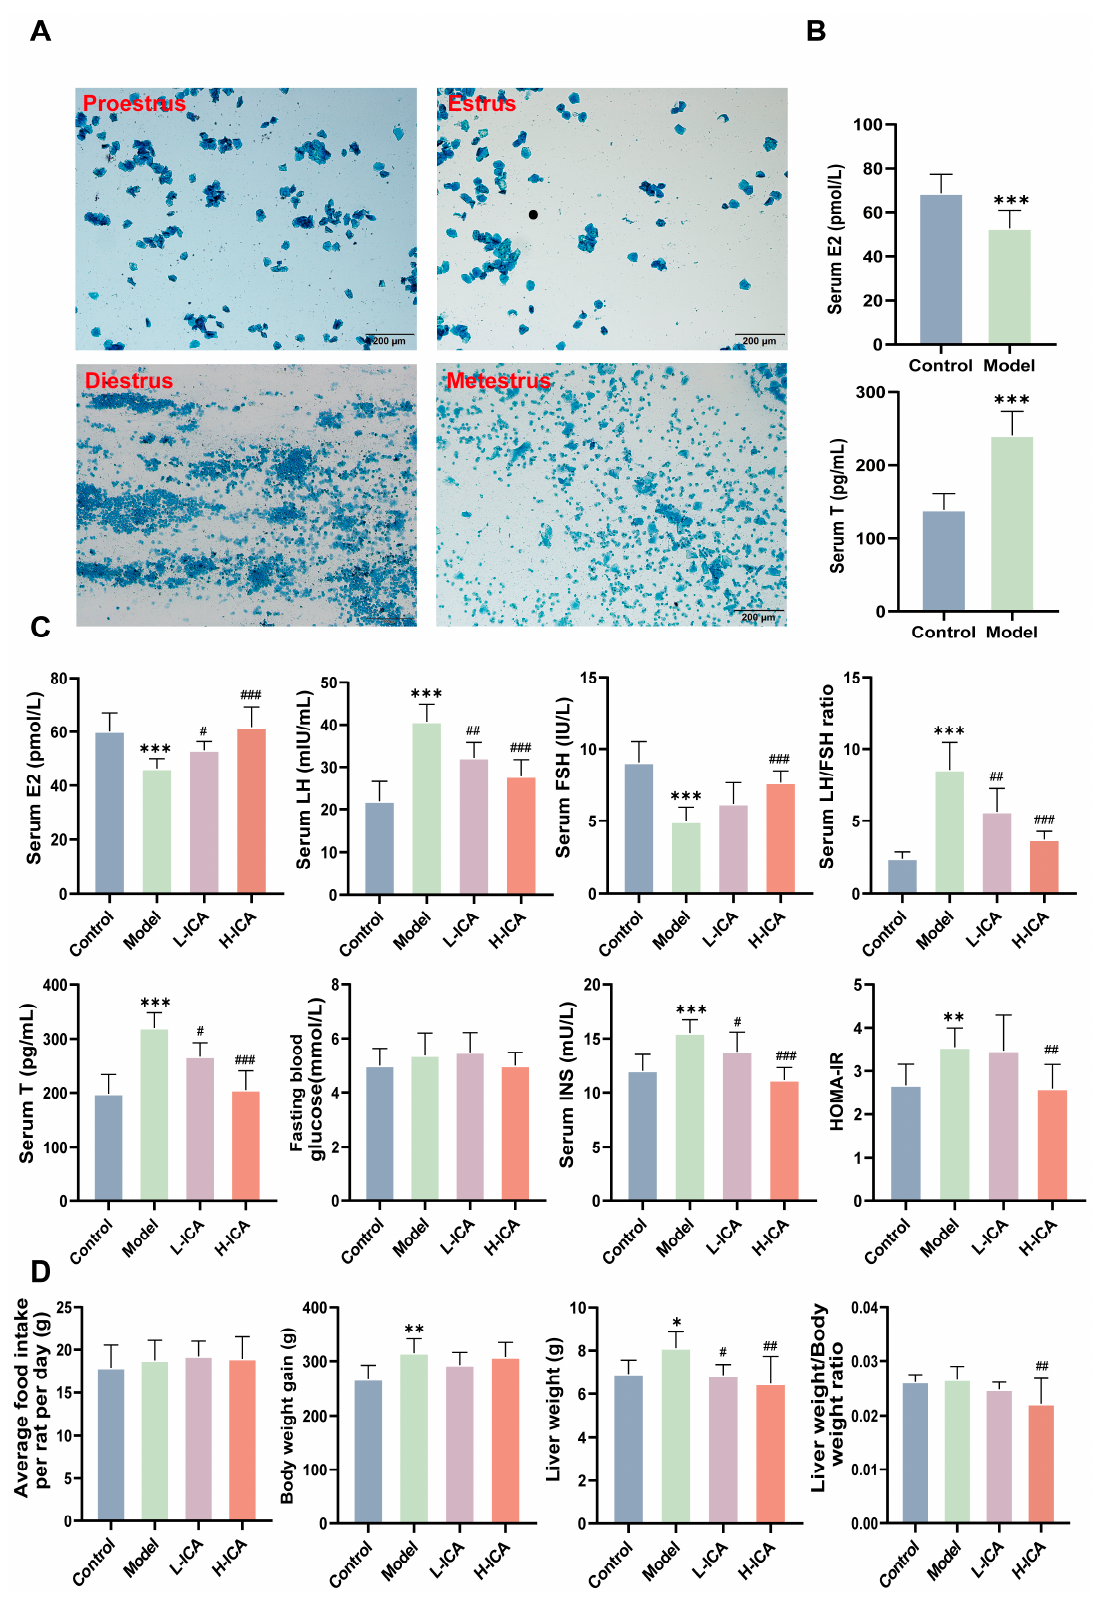
Figure 1. The rat model and sex hormone levels. The main types of vaginal exfoliated cells in vaginal smears of rats (scale bar = 200 µ m) ( A ). Proestrus: predominantly nucleated epithelial cells, Estrus: